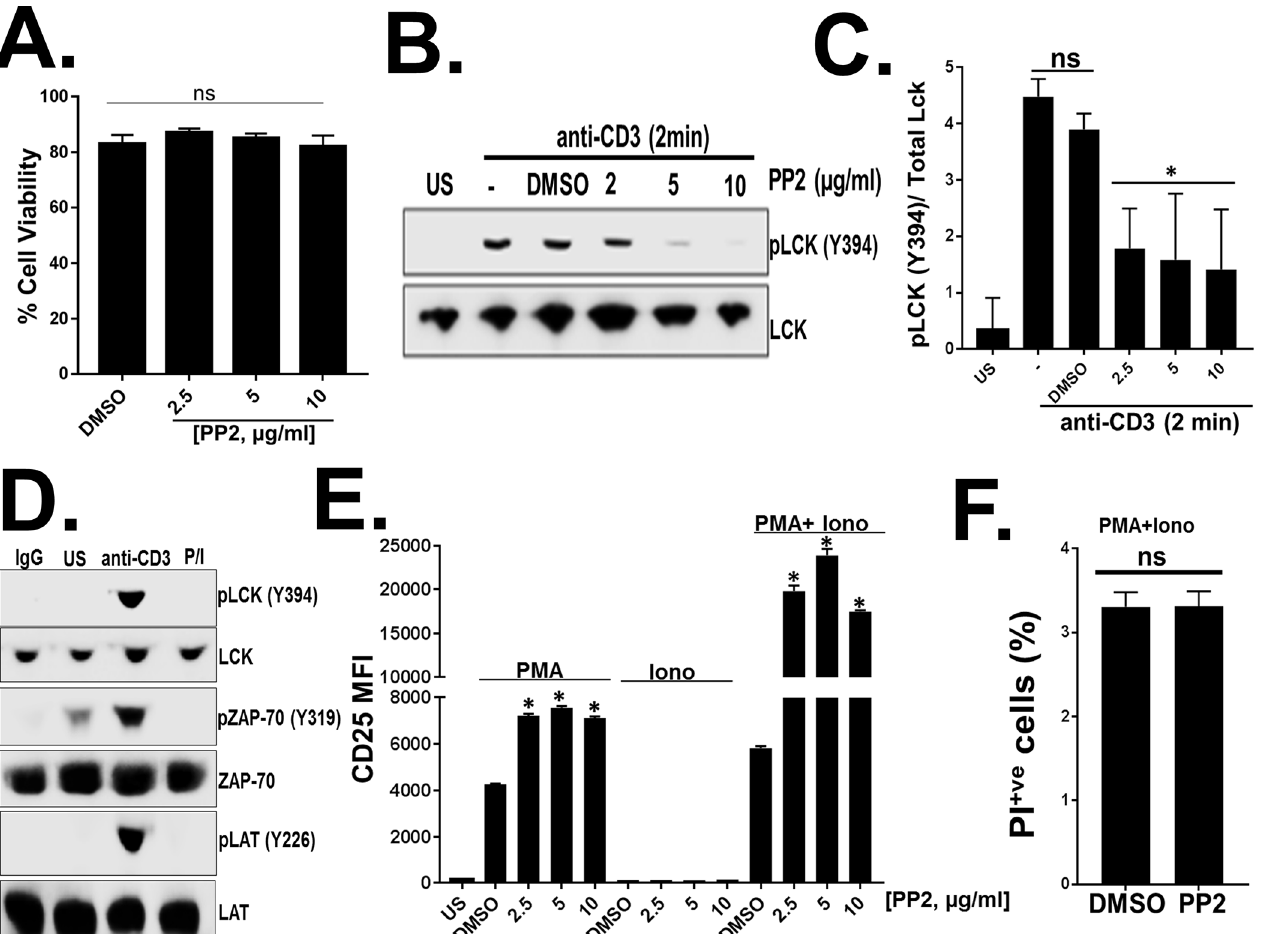
Fig 1. Inhibition of Src-family kinases (SFKs) by PP2 enhances distal T cell receptor(TCR) signaling. (A) Jurkat cell viability was measured following18 hours treatment with various concentrations of PP2 by trypan blue exclusion method. (B) Activation of SFKs was measuredin Jurkat T cells by assessing Lck phosphorylation at tyrosine 394 (Y394) followinganti-CD3stimulation(2 minutes) in presenceof variousconcentrations of PP2, DMSO or culture media (-) for 30 minutes. (C) Quantification of immunoblots from panel B obtainedfrom 3 independentexperiments. (D) Immunoblotanalysisof phosphorylated Lck (Y394), ZAP-70 (Y319) and LAT (Y226) following2 minutes of stimulationwith isotype control (IgG), anti-CD3IgG or PMA/Ionomycin. (E) CD25 surface expressionwas measured in Jurkat T cells following18 hours of DMSO alone or PP2 treatment and 24 hours of PMA, Ionomycin or PMA/Ionomycin stimulationby flow cytometry. (F) Propidiumiodidestainingof Jurkat T cells following18 hours of DMSO or PP2 treatment and 24 hours of PMA/Ionomycin stimulation.US = Unstimulated. Data represent the averageof three technical replicates, and the standarddeviationis shown. Each experiment was independently performed three times with similar results. * P < 0.01, ns = not significant.